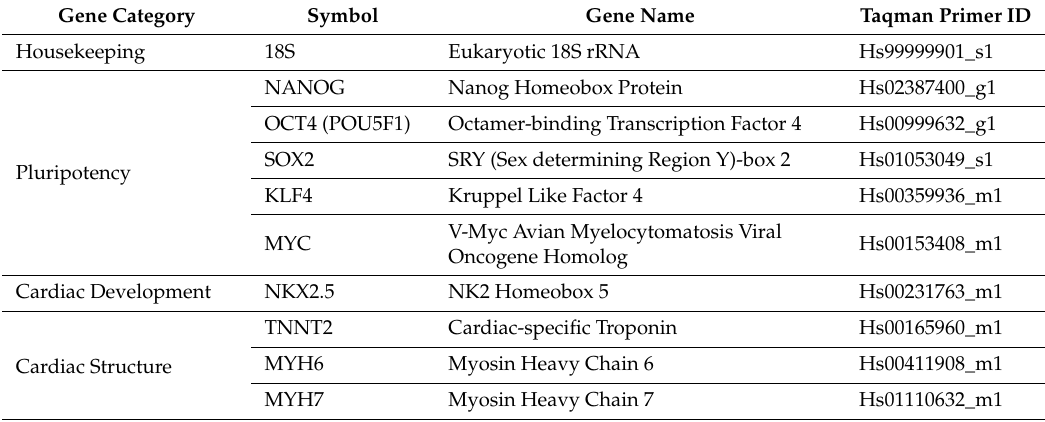
Table 2. Taqman gene expression assays used to prove the e ffi ciency of Chemically-Defined Medium